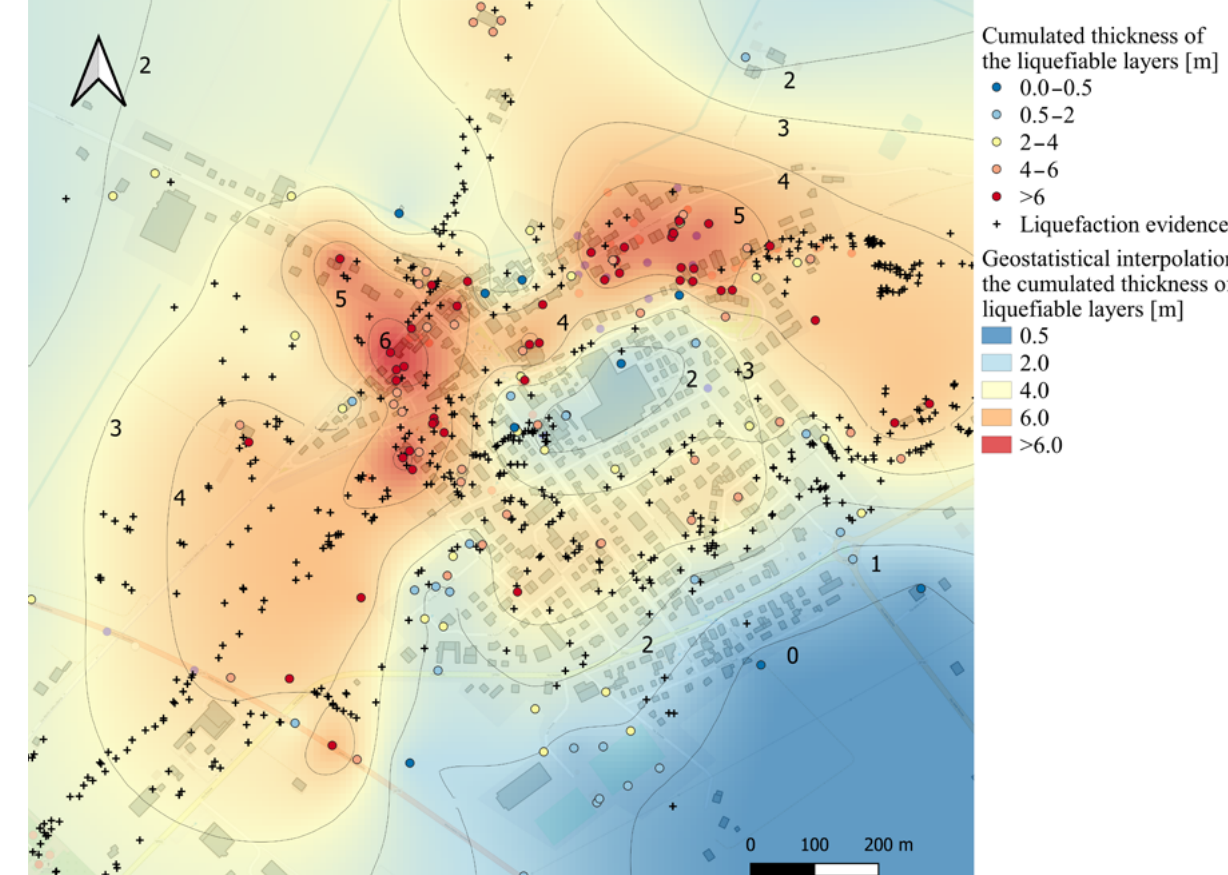
Figure 5. Geostatistical maps of the cumulated thickness of the liquefiable layer.